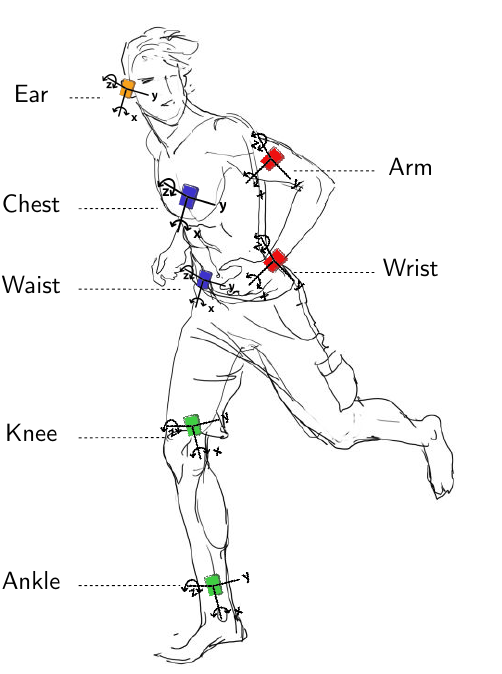
Figure 6. Various locations of wearable devices on the body. Illustration of a subject wearing the wearable sensors on the ear, chest, arm, wrist, waist, knee, and